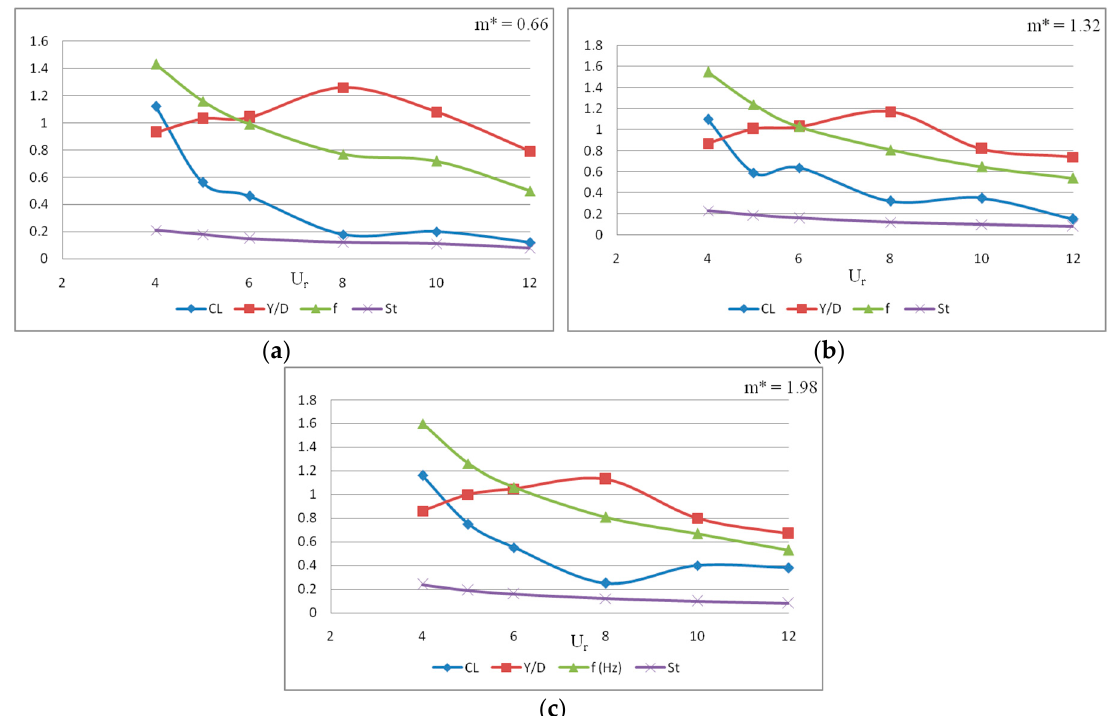
Figure 10. Effect of U r on various hydrodynamic and structural parameters for VIV of a cylinder ( a ) m* = 0.66; ( b ) m* = 1.32; ( c ) m* = 1.98.